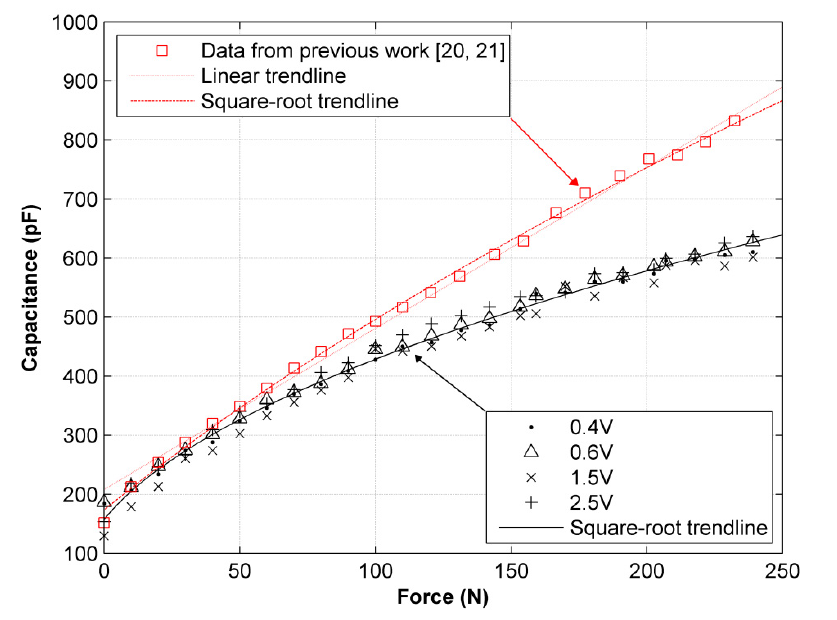
, measured using two different methods under different s